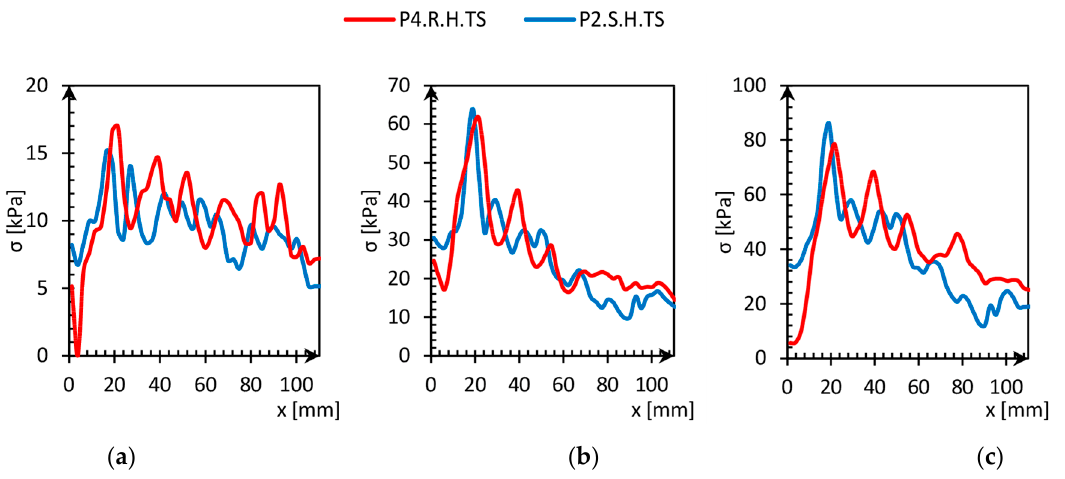
7.88 kPa, P3.S.0.5H.TS—7.06 kPa; ( b ) P1.R.0.5H.TS—9.90 kPa, P3.S.0.5H.TS—9.38 kPa; ( c ) P1.R.0.5H.TS—27.16 kPa, P3.S.0.5H.TS—11.09 kPa.